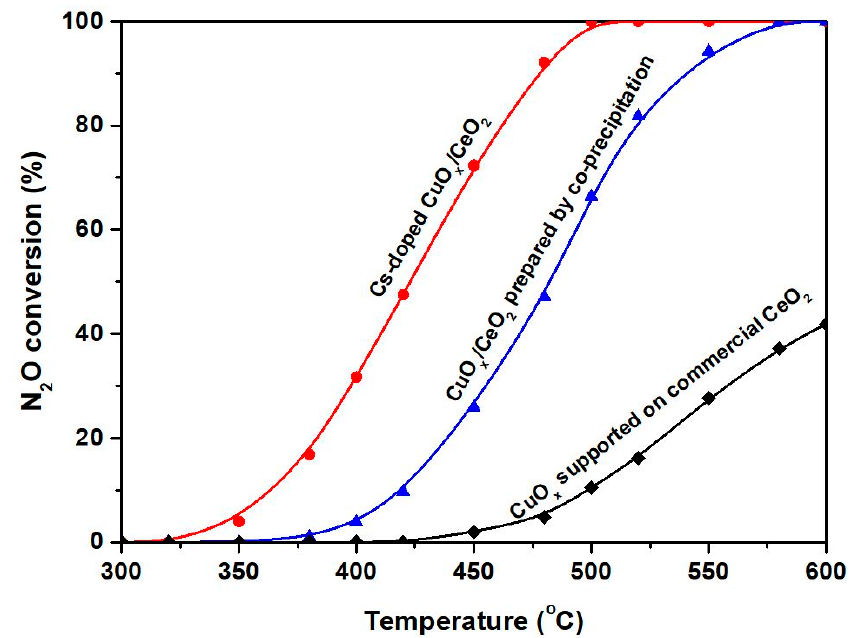
Figure 14. Optimization of deN 2 O performance of CuO x /CeO 2 mixed oxides by co-adjusting synthesis parameters (co-precipitation method) and electronic state (alkali addition). For comparison, the corresponding performance of CuO x supported on commercial ceria is included. Reaction conditions: